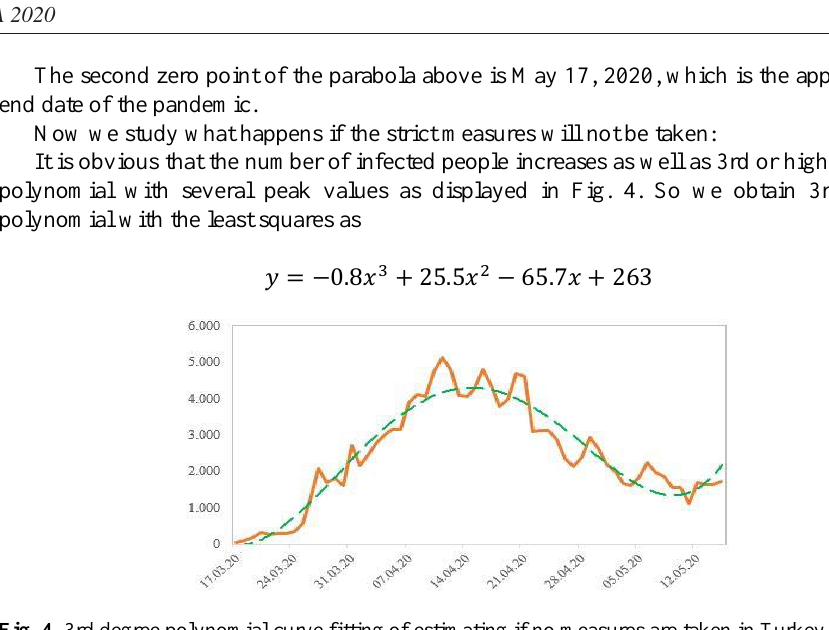
Fig. 4. 3rd degree polynomial curve fitting of estimating if no measures are taken in